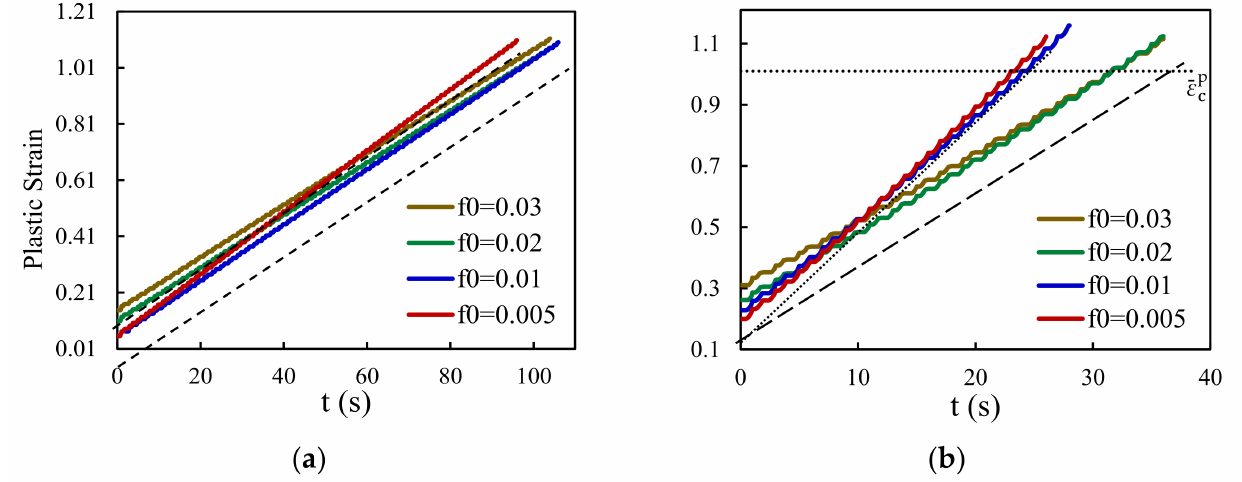
Figure 6. Plastic strain accumulation vs. pseudo-time for the different values of f 0 for : ( a ) a 0 = 11.5 mm; ( b ) a 0 = 19